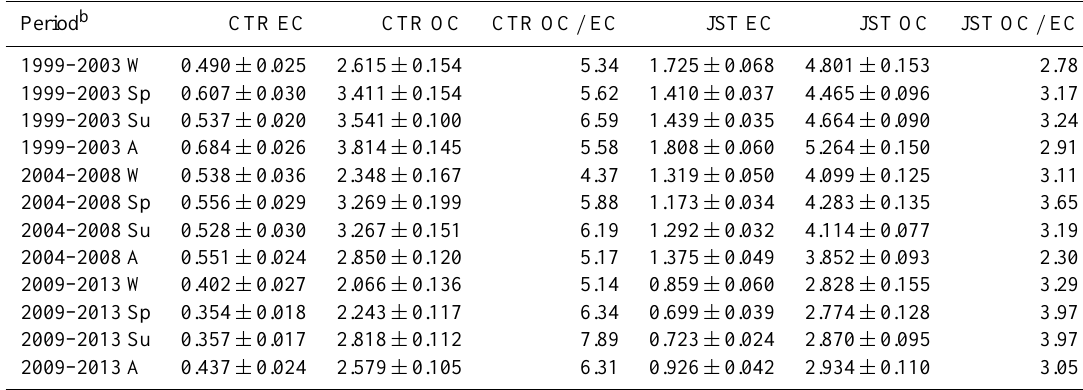
Table 1. In total, 5-year seasonal mean EC and OC concentrations at CTR and JST with mean OC / EC a . Period b CTR EC CTR